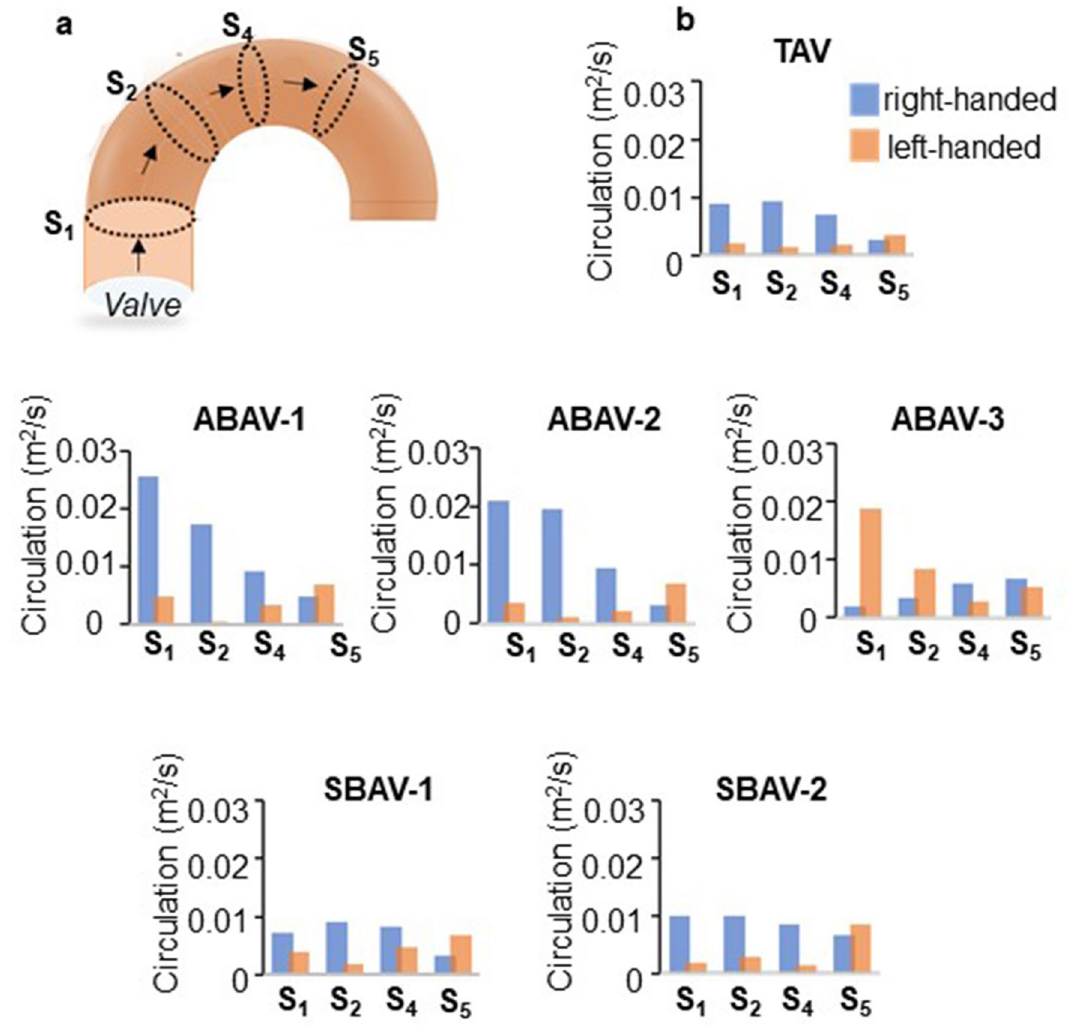
Figure 8. Characteristics of peak systolic circulation values in tricuspid aortic valve (TAV), three asymmetric bicuspid aortic valves (ABAVs), and two symmetric BAVs. ( a ) The position of the four cross-sections: at the level of the pulmonary bifurcation (S 1 ), distal edge of brachiocephalic artery (S 2 ), distal edge of the left subclavian artery (S 4 ), and fourth thoracic vertebra body upper edge (S 5 ). ( b ) Magnitudes of maximum circulation values (m 2 /s) at peak systole are measured at S 1 , S 2, S 4 , and S 5 (one sample, each). In the three asymmetric BAVs, the magnitudes of circulation values are markedly high in the ascending aorta, which decrease to approximately half and less than one third in the middle and distal parts of the aortic arch, respectively. In the two symmetric BAVs, the magnitudes of circulation values are comparable to that in